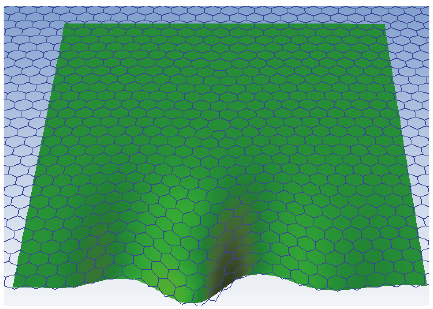
Figure 14: Fitting graphene’s surface by